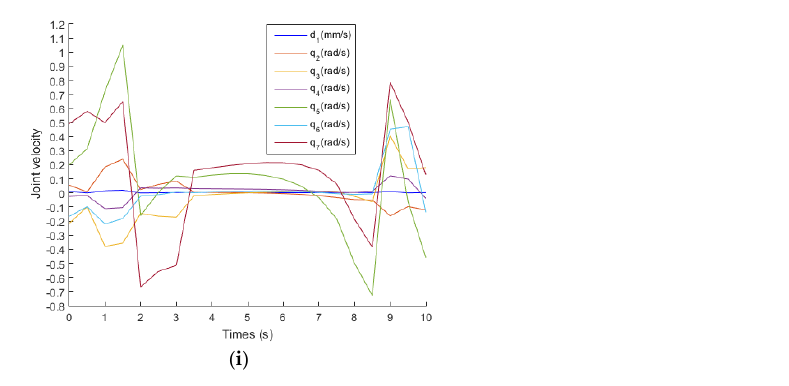
w q ; ( e ) the change curve of r ; ( f ) c i i F ; ( i ) the change curve of joint velocity. i